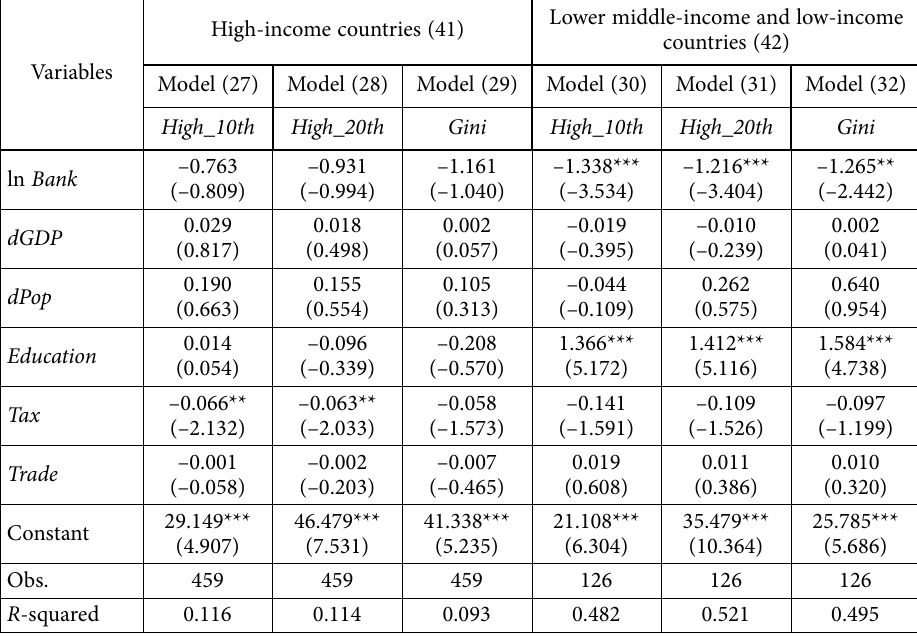
Table 8. Results of sub-samples classified by levels of economic